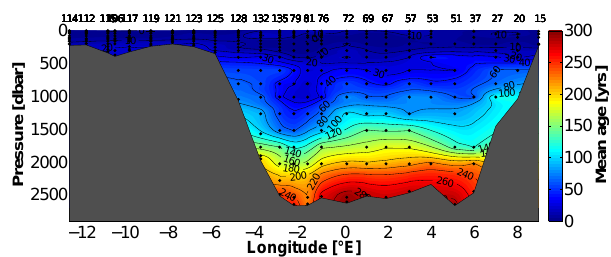
Figure 11. Distribution of the mean age based on saturation- corrected CFC-12 data below 200m and unaltered SF 6 data in shal- lower